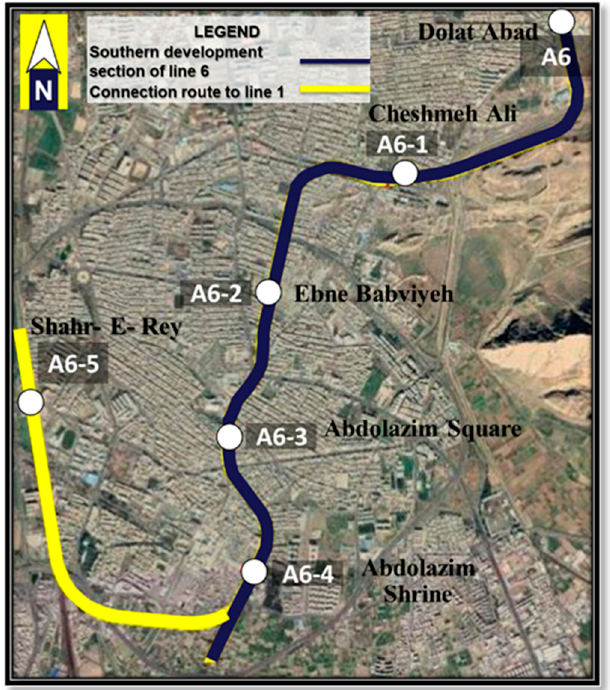
Figure 1. Plan view of the construction site (Southern Development Section of Line 6).